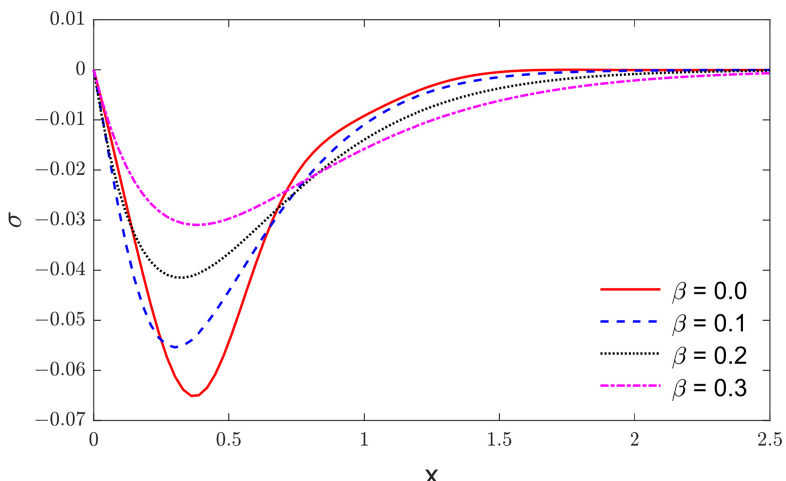
Figure 3. The impact of nonlocal parameter in the stress variations along the distance x when α = 0.3 and τ o = 0.05.